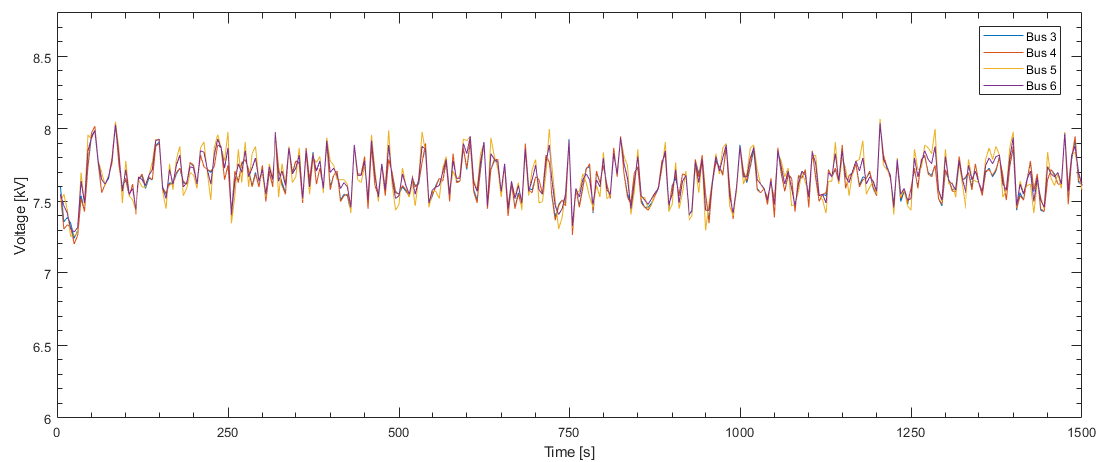
Figure 15. Voltage Profile in Island Mode.